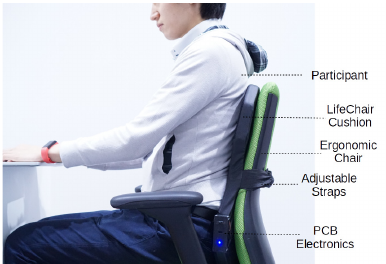
Figure 6. Experimental setup for classification